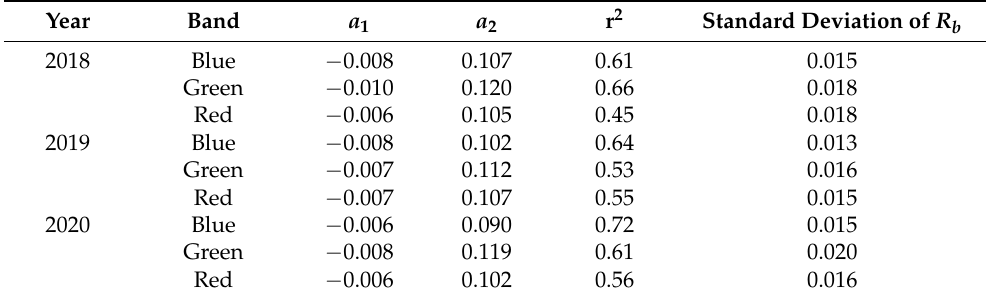
Table 1. The r 2 values and coefficients of the logarithmic regression ( 𝑅 𝑏 = 𝑎 1 𝑙𝑜𝑔(𝑑) + 𝑎 2 ) for the blue, green and red bands from 2018 to 2020 ( p < 0.05), where d is median particle size ( μm).